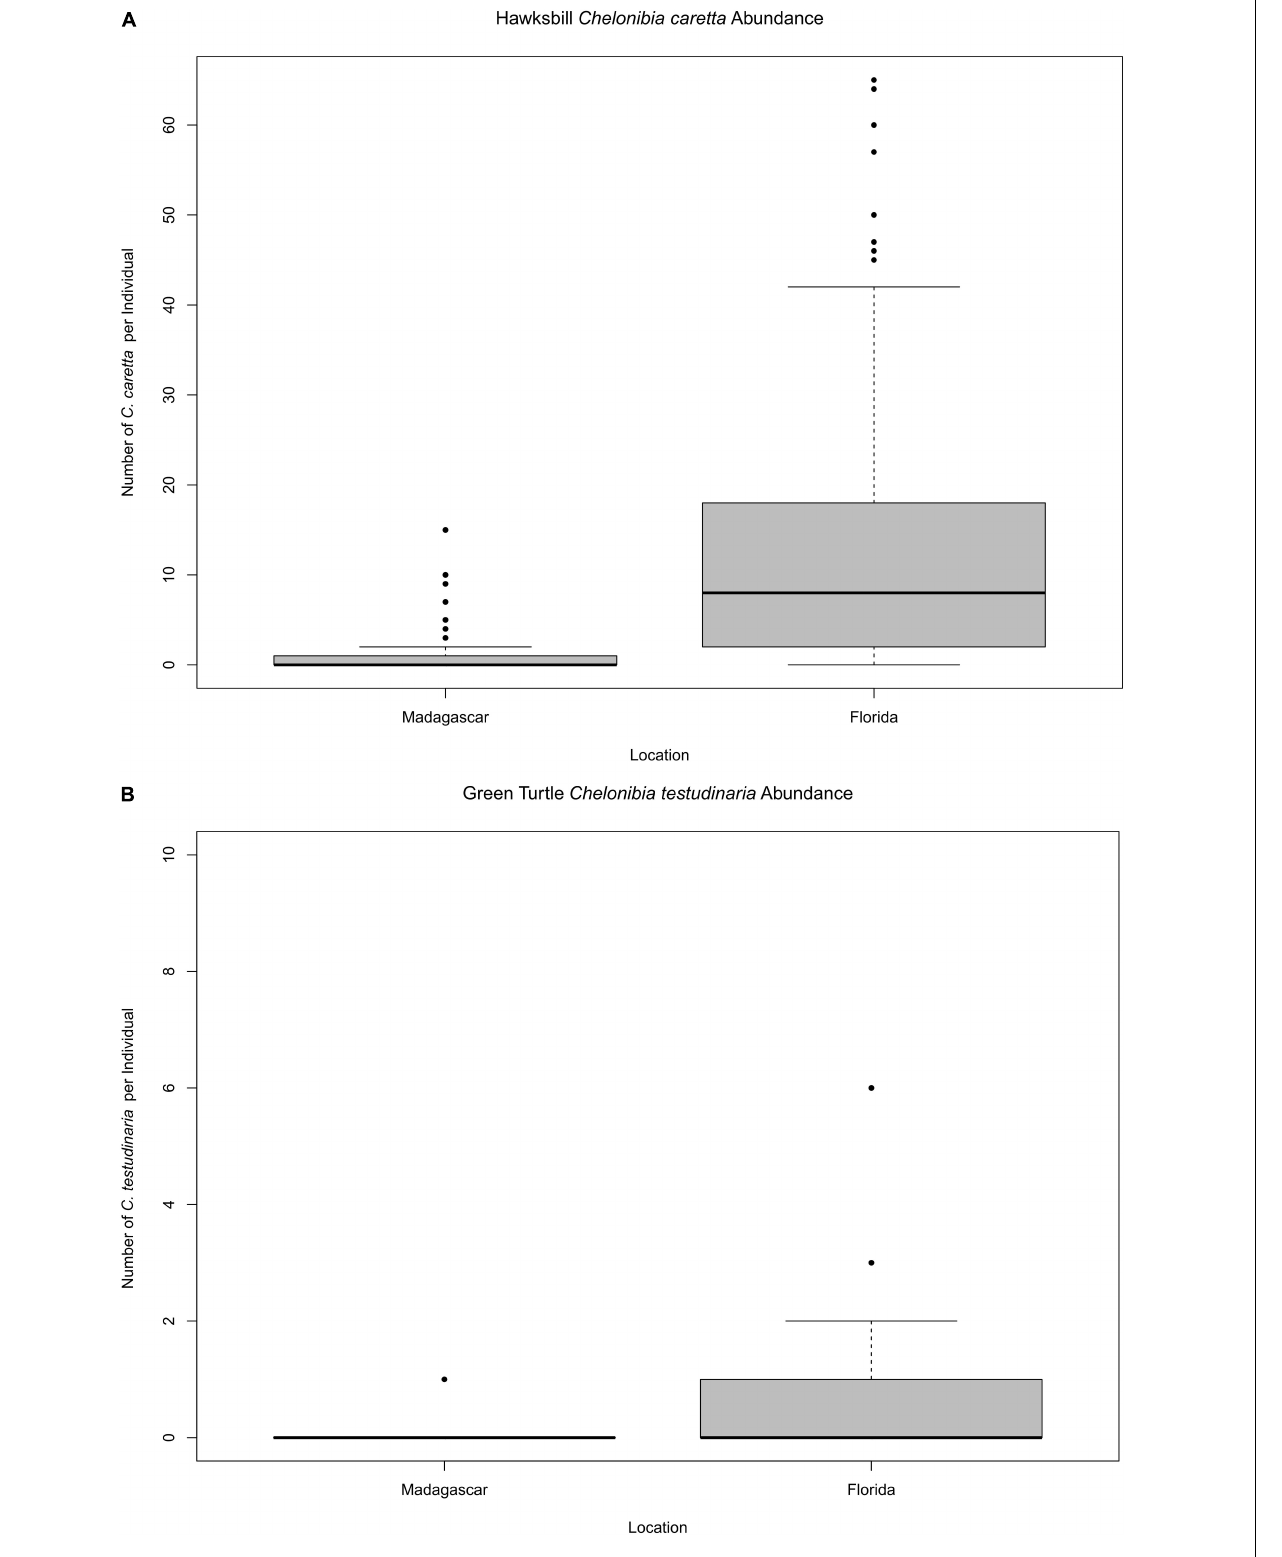
Frontiers in Ecology and Evolution |